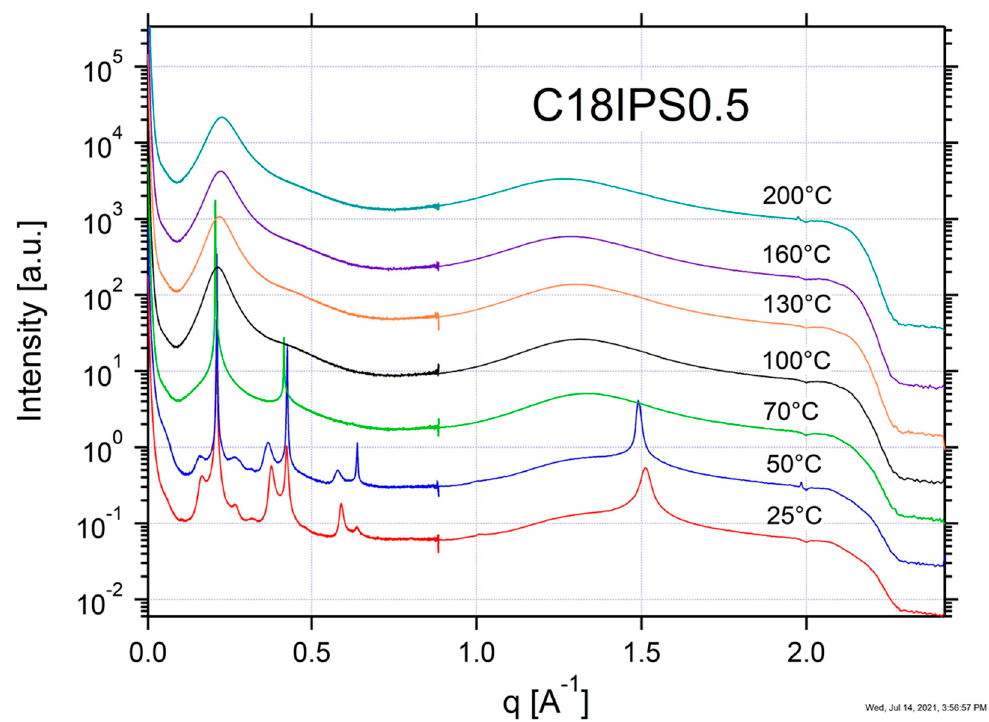
Figure A25. SAXS and WAXS data for 0.5:1 C18IPS:C18LiTFSI.